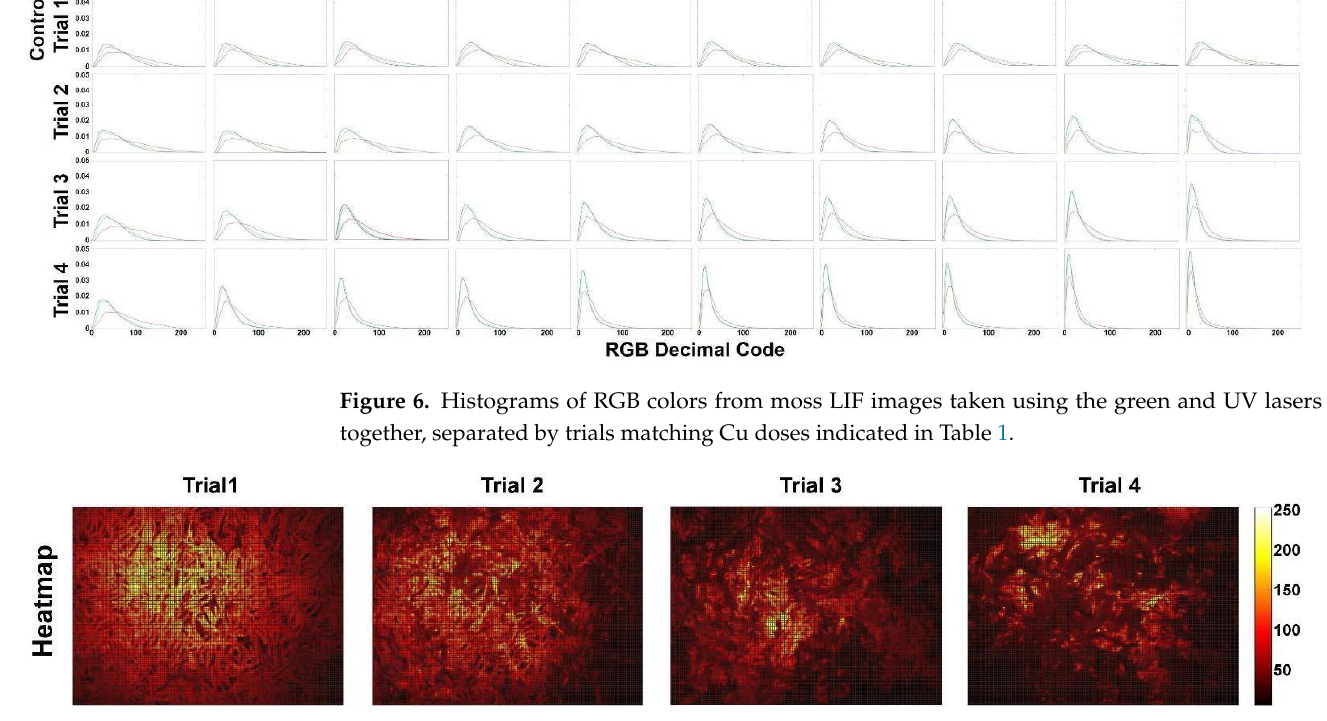
Figure 7. The red channel of images collected with the CMOS camera after LIF with Biofinder. The resolution of the images was reduced to 10% of their original size for easier analysis (150 × 200 pixels). Yellow colors represent the highest decimal codes while black represents the lowest.